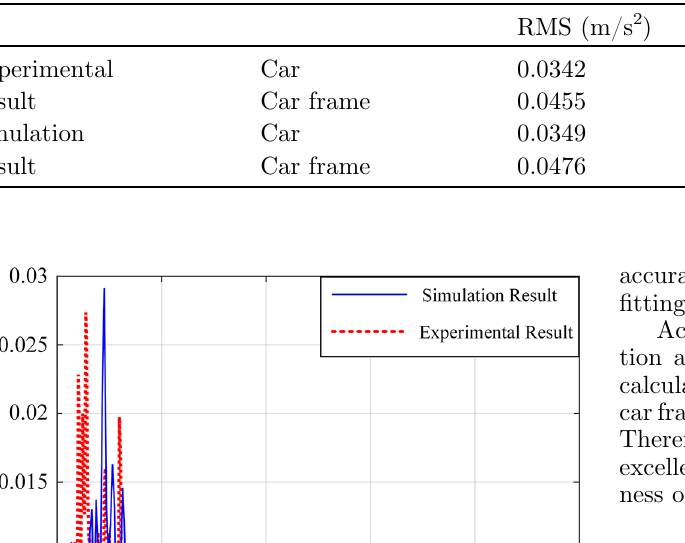
Table 2. Time-domain response results of horizontal vibration acceleration of the car and the car